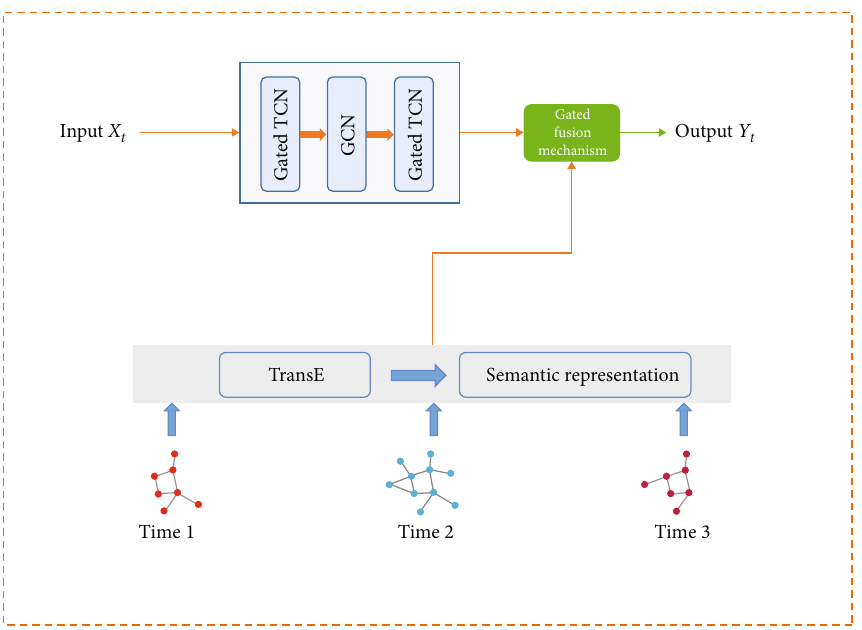
Figure 6: Metro tra ffi c fl ow prediction model based on knowledge graph representation learning. Table 4: Tra ffi c fl ow prediction results on the BJMF15 dataset.